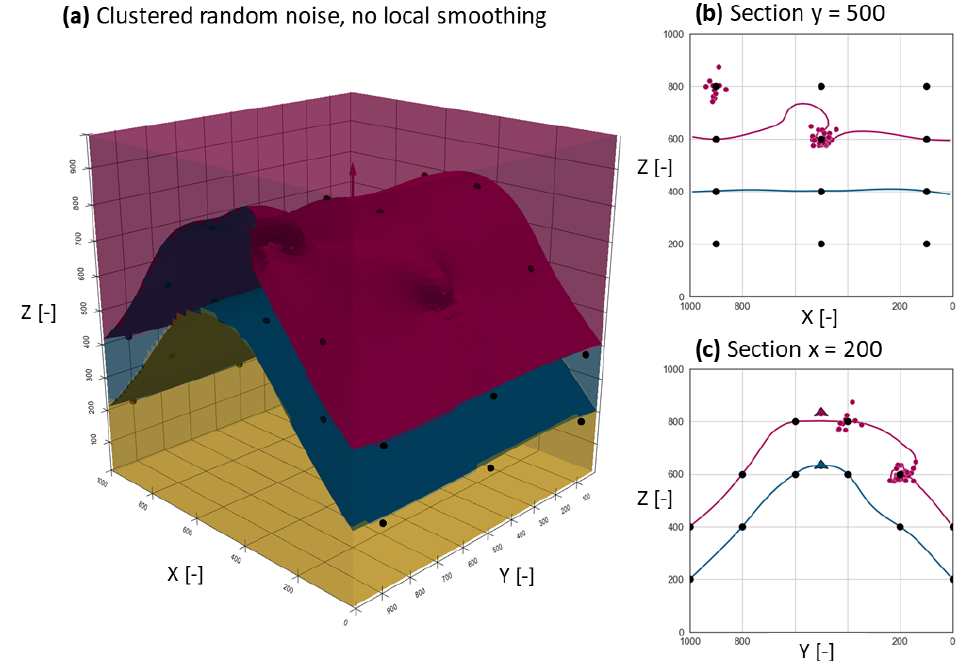
Figure 8. Geomodel of a folded unit. Two clusters of 25 noisy data points were added to the data from model in Figure 5. Original surface data points feature local smoothing of zero, added noisy data points have a local smoothing based on KDE. ( a ) 3D model view. ( b ) Section viewing at y = 500. ( c ) Section at x = 200. Note that input data are projected on section